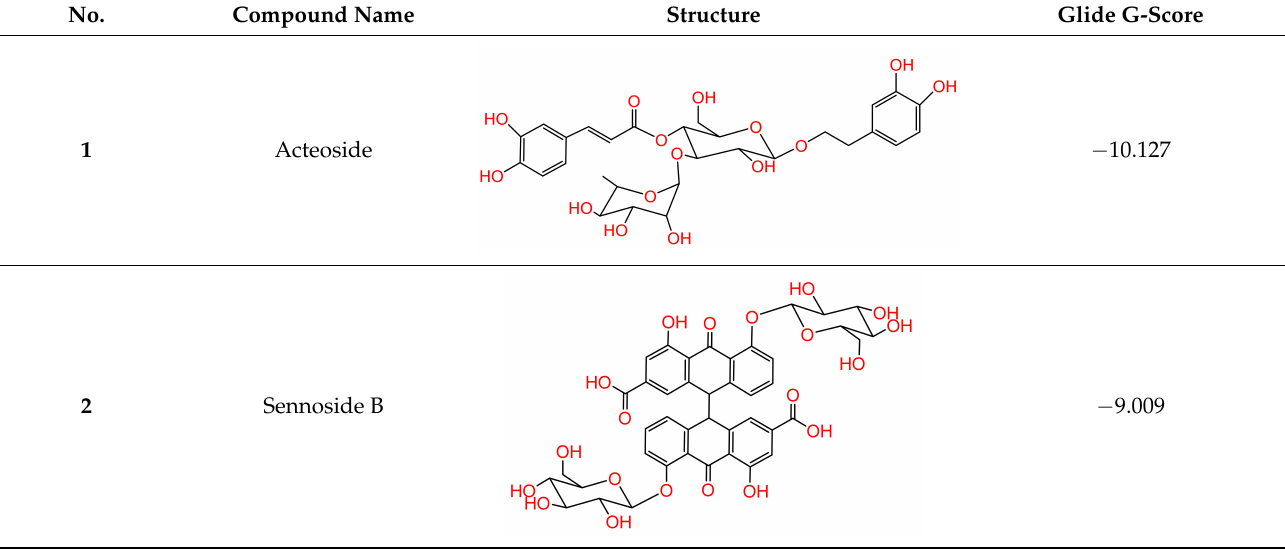
Table 1. The top hits of natural isolates with highest affinity to the viral protease (SARS-CoV-2 M PRO ).